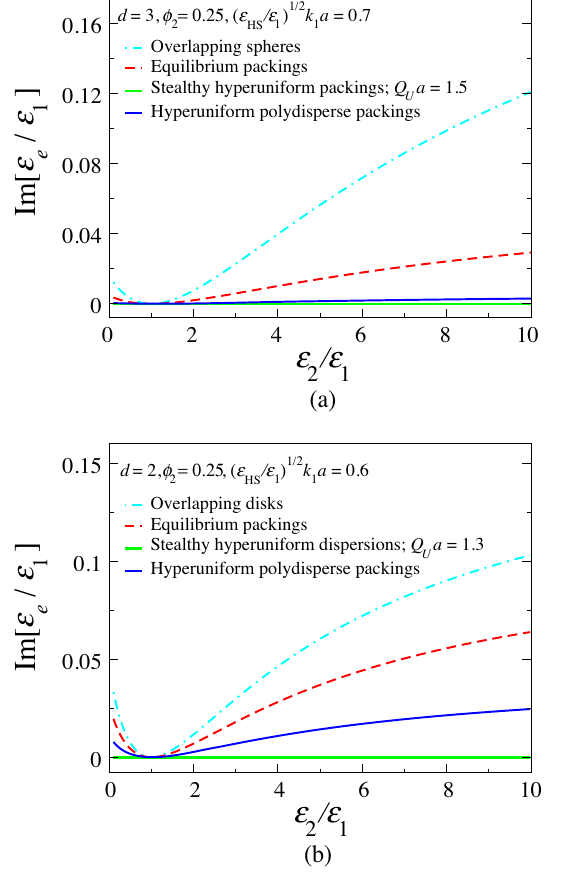
FIG. 11. Predictions of the strong-contrast approximation (73) for the effective dynamic dielectric constant ε of the dielectric-contrast ratio ε 2 = ε 1 for the four disordered models, as per Fig. 10, at packing fraction ϕ 2 ¼ 0 . 25 and wave ffiffiffiffiffiffiffiffiffiffiffiffiffiffi p ε = ε 1 ffiffiffiffiffiffiffiffiffiffiffiffiffiffi p HS ε = ε 1 k 1 a ¼ 0 . 6 in two dimensions. HS